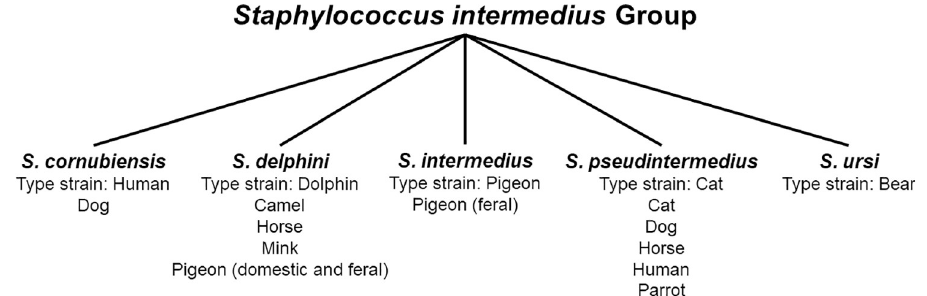
Fig 1. Members of the S. intermedius group and host associations. Host associations based upon data presented in [5,6,67,70]. The animal sources of the type strains ( Staphylococcus cornubiensis NW1 T , Staphylococcus delphini DSM 20771 T , Staphylococcus intermedius DSM 20373 T , Staphylococcus pseudintermedius DSM 21284 T , and Staphylococcus ursi MI 10-1553 T ) are indicated, and host associations of the different species are listed underneath. The human isolates likely reflect transmission from animal sources. In the case of S . cornubiensis , the type strain was recovered from a human [67]; however, a related isolate (2008-01-1056-2) was recovered from a dog [71], suggestive of an animal link. All members, with the notable exception of S . ursi , are coagulase